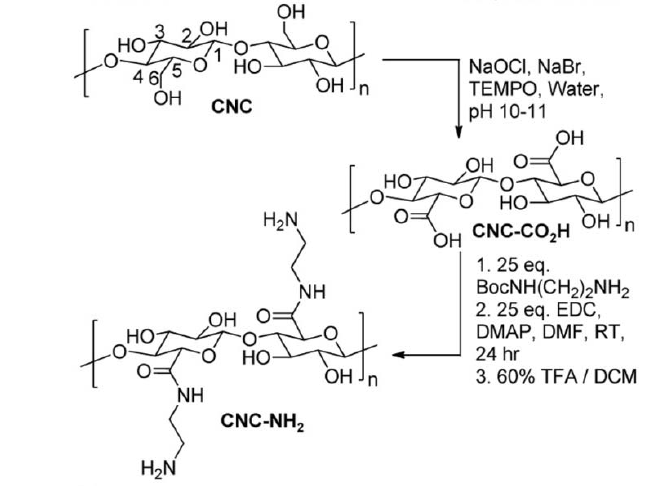
Figure 12. Synthesis route of pH-responsive CNCs (carboxylated CNCs and amine-functionalized CNCs). Reprinted with permission from [72]. Copyright 2012 American Chemical Society.